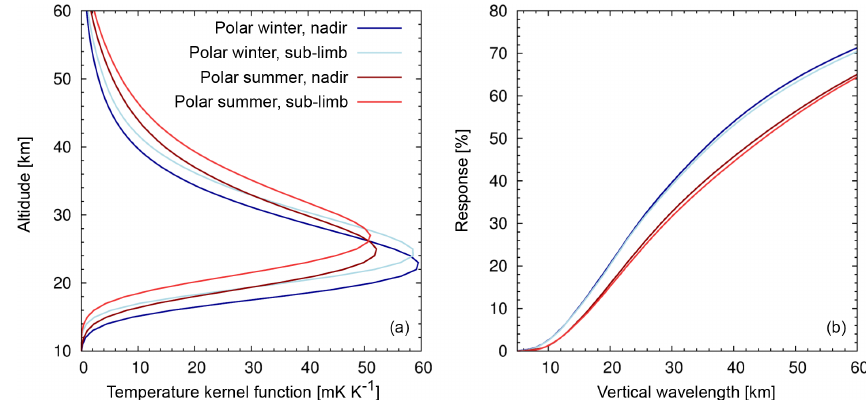
Figure 1. Temperature-weighting functions (left) and amplitude response curves (right) for the AIRS 15µm brightness temperature data set. Radiative transfer calculations have been performed for polar summer and polar winter conditions, the nadir direction and the outermost scan angles (referred to as “sub-limb”), and a 1km altitude grid.